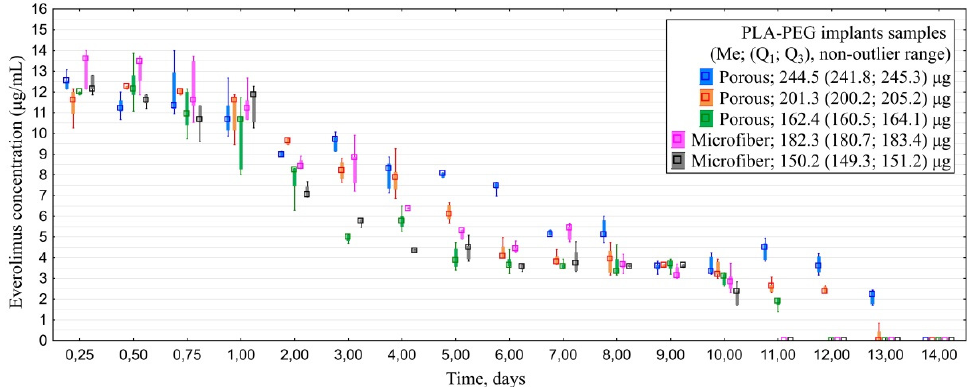
Figure 6. Dynamics of everolimus release from PLA-PEG implants samples depending on their structure and initial everolimus amount.